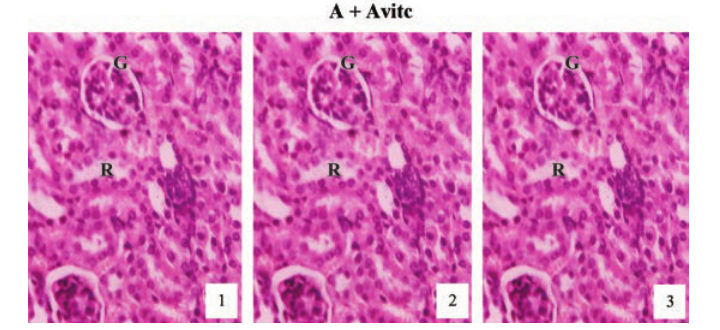
Figure 7. Hematoxylin and eosin staining after administration of 0 mg/kg of paraquat representing control subgroups maintained with no vitamin C and vitamin C medicated (1 g/L) water (A and Avitc) respectively for a period of 3 months (original magnification 400X). The slides represent results obtained at months 1, 2 and 3. The results are show- ing normal architecture. The renal corpuscles, Bowman’s capsules, glomeruli (G) and convoluted tubules presented normal features.